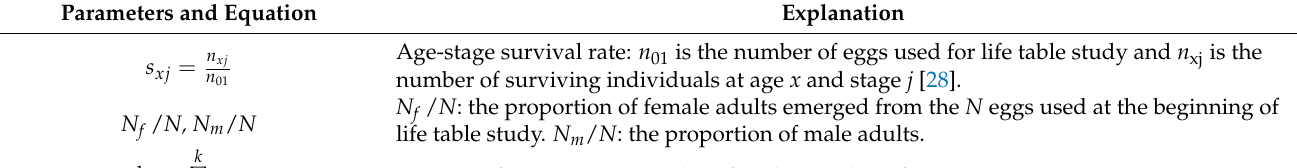
Table A1. Parameters, equations, and definitions used in this life table analysis. Parameters and Equation